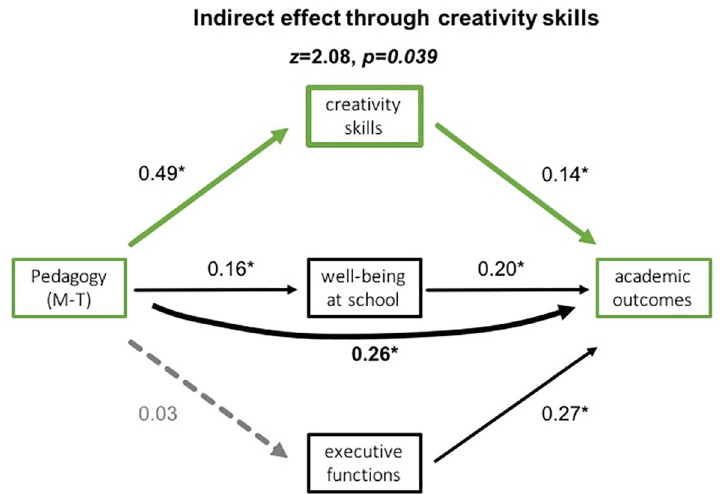
Fig 1. Multiple mediation model (according to [31]) for the indirect effect of children’s school system (Montessori vs. traditional) via multiple mediators (executive functions, well-being at school, and creativity skills) on academic outcomes. The only significant ( z > 2) indirect mediation effect on academic outcomes was creativity skills in Montessori schoolchildren (green path). The standardized solution coefficients (ß) and significant p -values < 0.05 (depicted with a star) are reported next to related